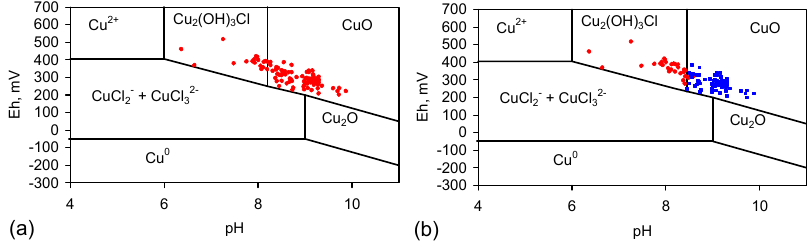
Figure 7. ST3f Trial Pellet [16]. ( a ) Standard Redox Stability fields for copper in the saline system Cu-